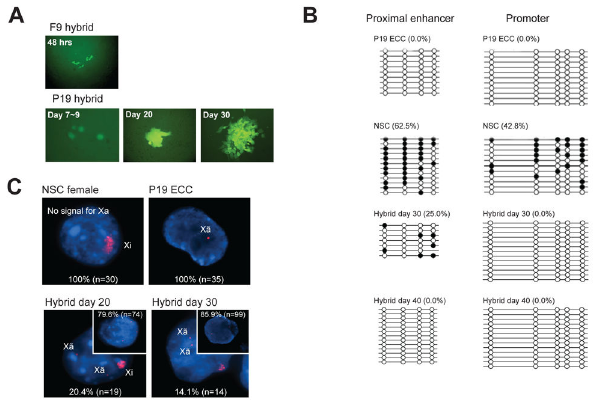
Figure 2. Low reprogramming potential of mouse epiblast- derived pluripotent stem cells. ( A ) Reprogramming potential of F9 and P19 ECCs was determined by monitoring the time required to reactivate the Oct4 -GFP transgene in the reprogrammed somatic genome. ( B ) DNA methylation state of the Oct4 regulatory regions (promoter and proximal enhancer) in P19 hybrids was analyzed using the bisulfite sequencing method. Open and filled circles indicate unmethylated and methylated CpGs, respectively. ( C ) X chromosome state was determined by Xist / Tsix RNA FISH. DNA was counterstained with 4,6-diamidino-2-phenylindole (DAPI; blue). Xist / Tsix RNA was detected as a large signal in inactive X chromosome (Xi), a pinpoint signal in active X chromosome (Xã; pluripotent cell type), and no signal in active X chromosome (Xa; somatic cell type). In P19 hybrids, the large signal (typical Xi) of female NSCs gradually changed into pinpoint signals, indicating that the X chromosome of the somatic cell genome had been reactivated as in pluripotent P19